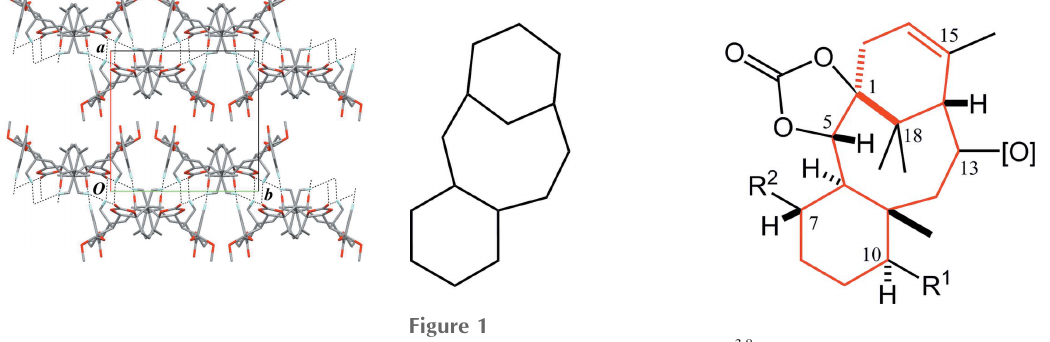
Figure 1 Left: Structure of the tricyclo[9.3.1.0 3,8 ]pentadecane (taxane) skeleton; Right: Core structure of the title compounds. Red lines indicate the taxane skeleton. R 1 = OC( O)Ph, R 2 = OCH 2 OCH 3